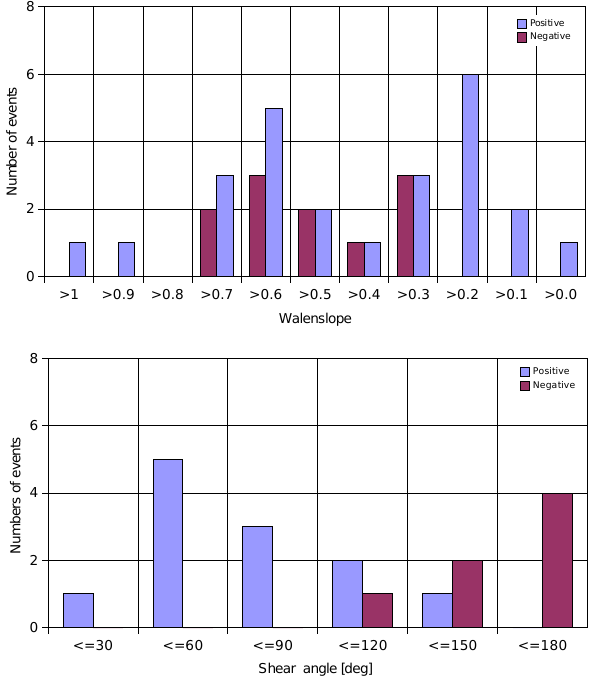
Fig. 13. Top: Histogram of Wal´en slopes, for all cases where the correlation coefficient magnitude exceeded 0.85. Positive and neg- ative slopes are shown with different colors. Bottom: Subset of cases with slopes of magnitude > 0.5, divided according to the sign of the slopes, versus the magntitude of the magnetic shear across the